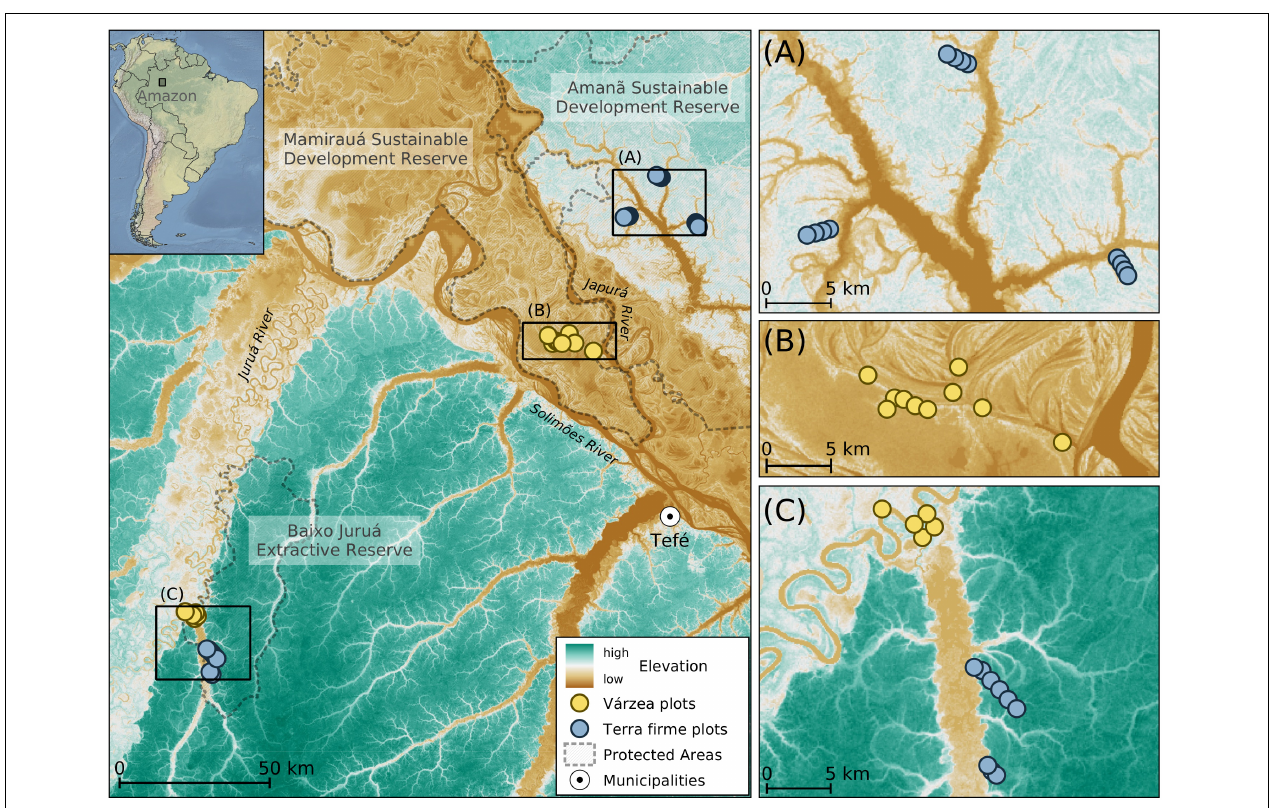
FIGURE 1 | Distribution of sample plots in várzea and terra firme forests. Maps show the distribution of sampling plots overlapped with an elevation Radar image from the Shuttle Radar Topography Mission (SRTM). Black rectangles in the left map are enlarged in right panels (A–C)